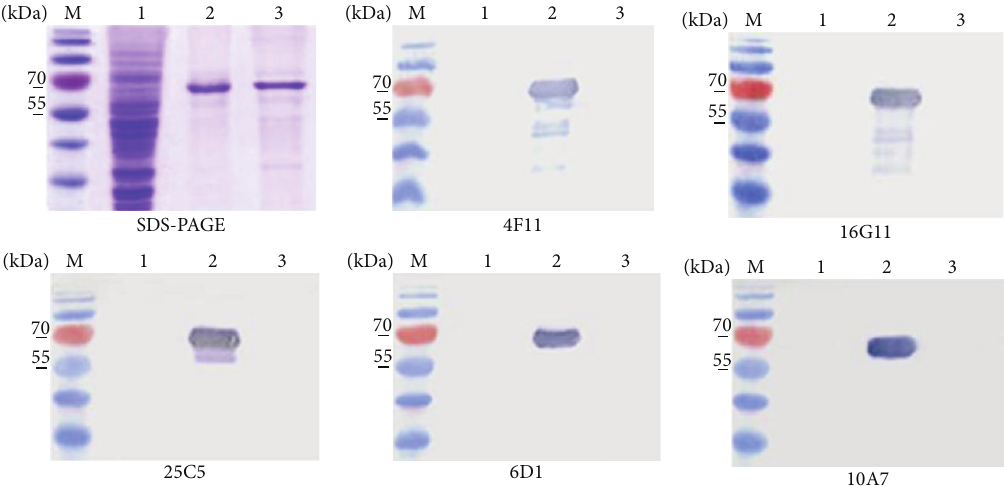
Figure 3: Western Blot analysis of MAbs raised against PPV VP2. Lanes 1: lysates of S. cerevisiae harboring plasmids pFX7; lanes 2 and 3: yeast synthesized recombinant PPV and human bocavirus 1 VP2 proteins, respectively. PageRuler Prestained Protein Ladder (Fermentas/Thermo Fisher Scientific) was used as molecular mass standard in lanes M. MAb number used in each WB is indicated below the corresponding blot picture. Only blots for linear-epitope recognizing MAbs are